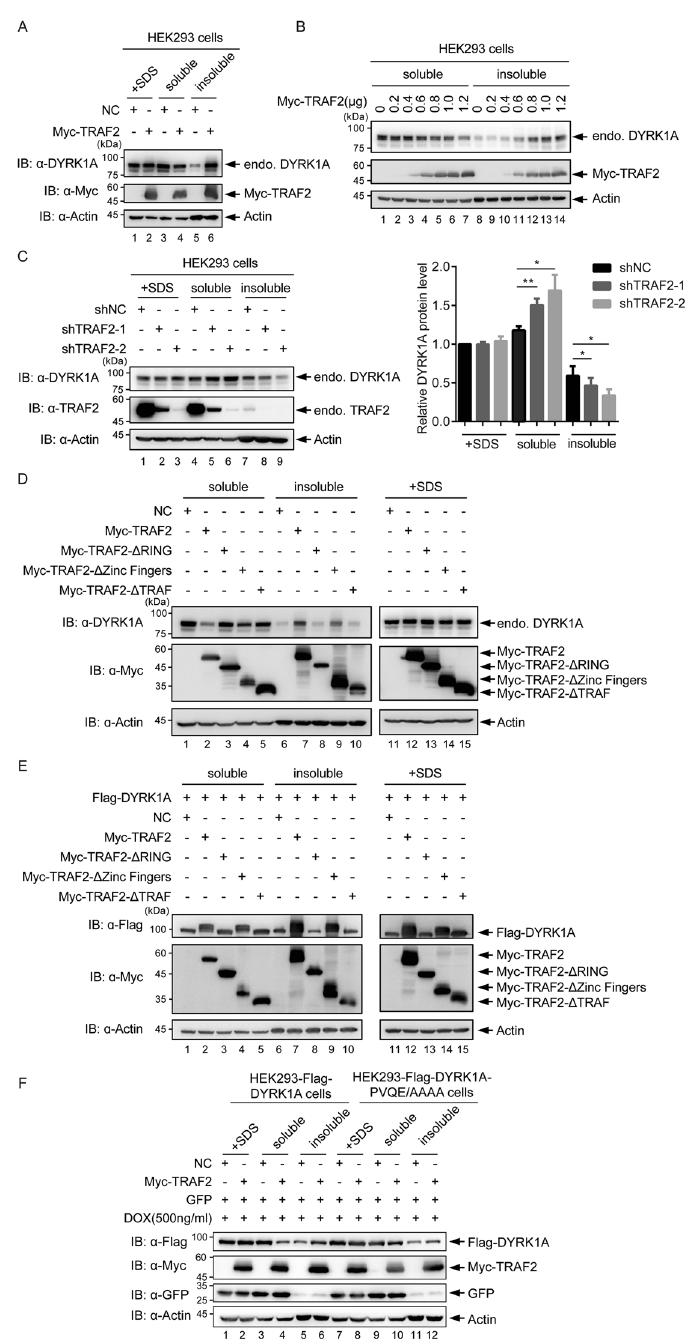
Fig. 4 TRAF2 is critical for translocation of DYRK1A to a detergent-insoluble fraction. A Distribution of DYRK1A in soluble and insoluble fractions. HEK293 cells transfected with Myc-TRAF2 were lysed in Tris buffer containing 0.5% Triton X-100, and soluble and insoluble fractions were separated by centrifugation. Whole-cell lysates were prepared by directly lysing the cells in SDS loading buffer. B DYRK1A distribution in soluble and insoluble fractions with increasing expression of TRAF2. Increasing amounts of Myc-TRAF2 were transfected and cells fractionated to obtain soluble and insoluble fractions as in A . With increasing amounts of TRAF2, soluble DYRK1A decreases, whereas the insoluble fraction increases. C Knockdown of TRAF2 affects distribution of DYRK1A in soluble and insoluble fractions. TRAF2 was silenced using two different shRNAs and cells fractionated. Amount of DYRK1A in the soluble fraction increases upon TRAF2 knockdown, whereas it decreases in the insoluble fraction. Also, the effect depends on the ef fi ciency of TRAF2 silencing. Right panel shows quanti fi cation of three independent experiments. Data were shown as mean ±SD, * P <0.05 and ** P < 0.01. D Analysis of TRAF2 domains responsible for distribution of DYRK1A to soluble and insoluble fractions. TRAF2 truncates and full-length TRAF2 were transfected in HEK293 cells, and cells fractionated. The presence of endogenous DYRK1A in soluble and insoluble fractions were determined. RING domain and TRAF domain truncates were unable to translocate DYRK1A to insoluble fraction. E Analysis of TRAF2 domains responsible for distribution of exogenous DYRK1A to soluble and insoluble fractions. Exogenous Flag-DYRK1A was transfected additionally to the D experiment and distribution of Flag-DYRK1A probed. F Analysis of distribution of Flag-DYRK1A-PVQE/AAAA in soluble and insoluble fractions. Lentiviruses were used to express Flag-DYRK1A or Flag-DYRK1A-PVQE/AAAA in HEK293 cells and their distribution analyzed after overexpression of TRAF2. Flag-DYRK1A-PVQE/AAAA does not translocate to insoluble fraction as ef fi ciently as WT